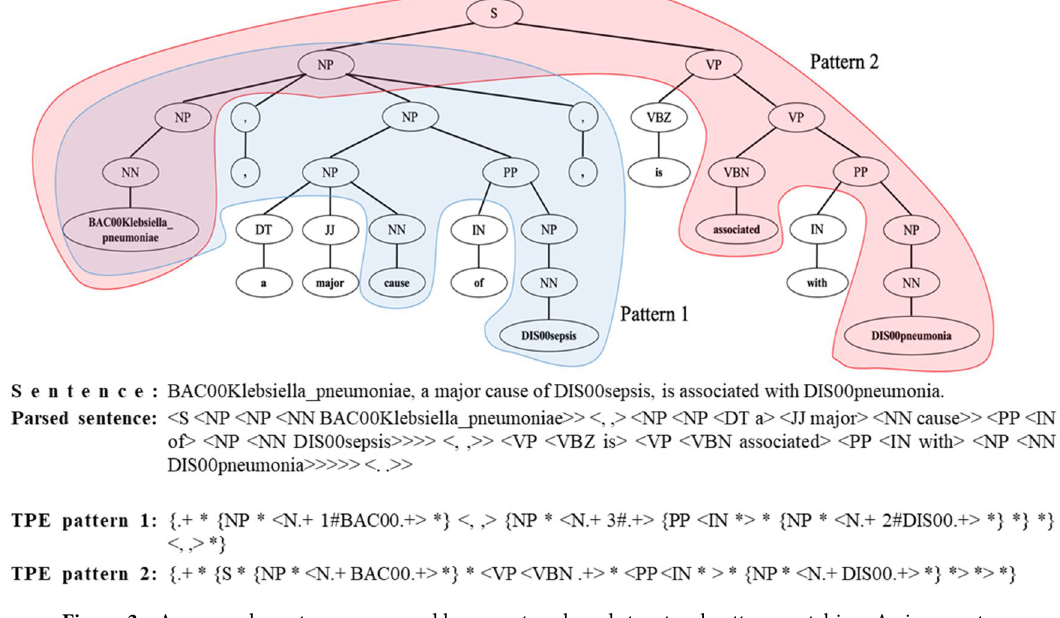
Figure 3. An example sentence processed by parse tree-based structural pattern matching. A given sentence is parsed to find the structural dependency. From the parsed sentence, two different tree pattern expressions, TPE pattern 1 and 2 were extracted from 59 predefined TPE patterns. The TPE pattern 1 (in blue) extracts the microbe-disease-relation triplet of (DIS00sepsis, BAC00Klebsiella_pneumoniae, cause). The TPE pattern 2 (in red) extracts the other triplet of (DIS00pneumonia, BAC00KLEbsiella_pneumoniae,